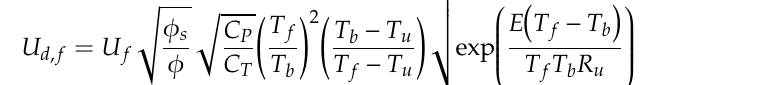
Figure 12. Comparison of our theoretical formulation with the experiments [31] and computational simulations [6] (FAST, yellow, and ALLA, blue). The flame tip velocity vs. its position for the blockage ratios (cid:2009) = 0.3 ( a ) and 0.6 ( b ).